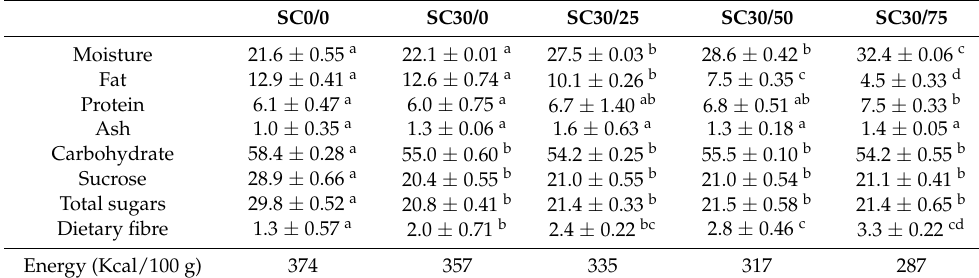
Table 6. Proximate composition (%) of sponge cake